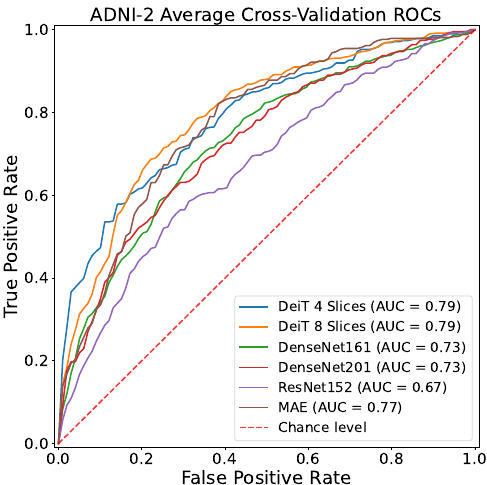
Figure 3. Cross-Validation ROCs related to ADNI-2